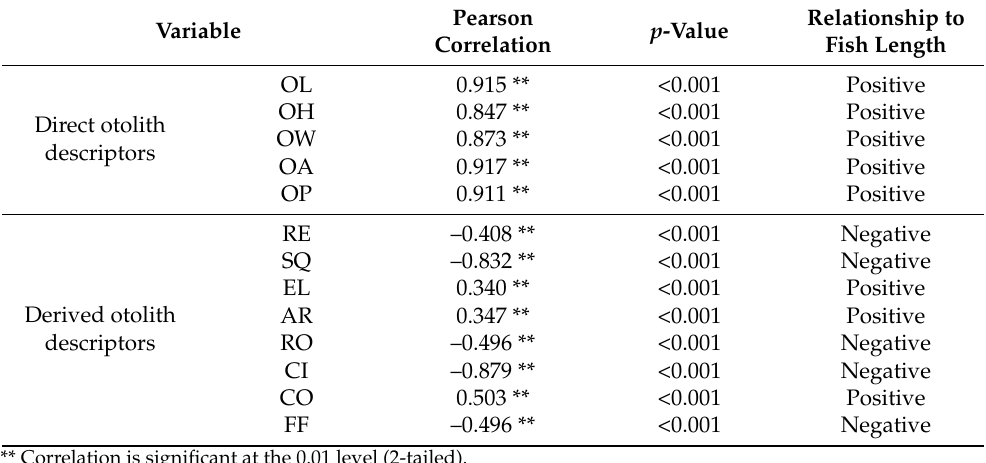
Table 3. Statistical relationships between D. kurroides otolith descriptors and fish total length.